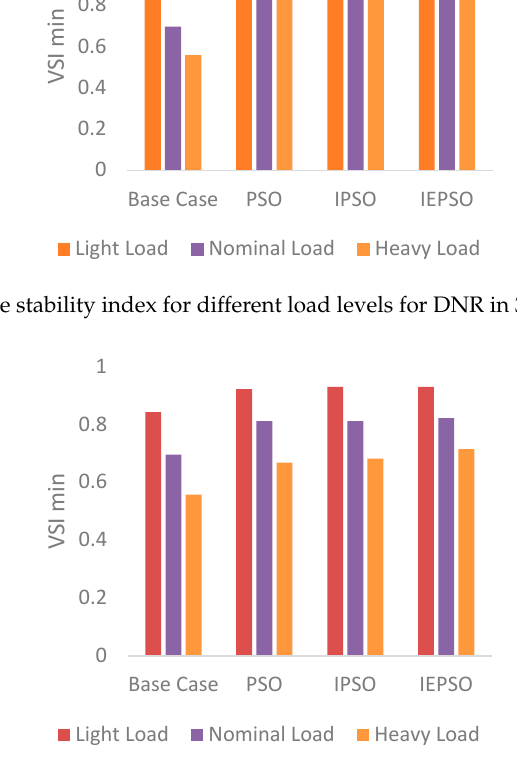
Figure 6. Voltage stability index for different load levels for DNR with DG in 33-bus test system.